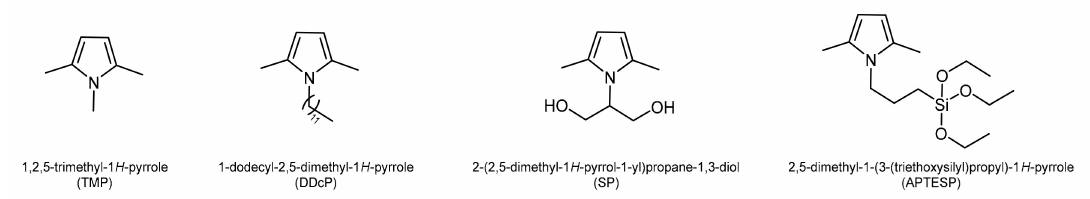
Figure 1. Chemical structures, IUPAC names and acronyms of pyrrole compounds